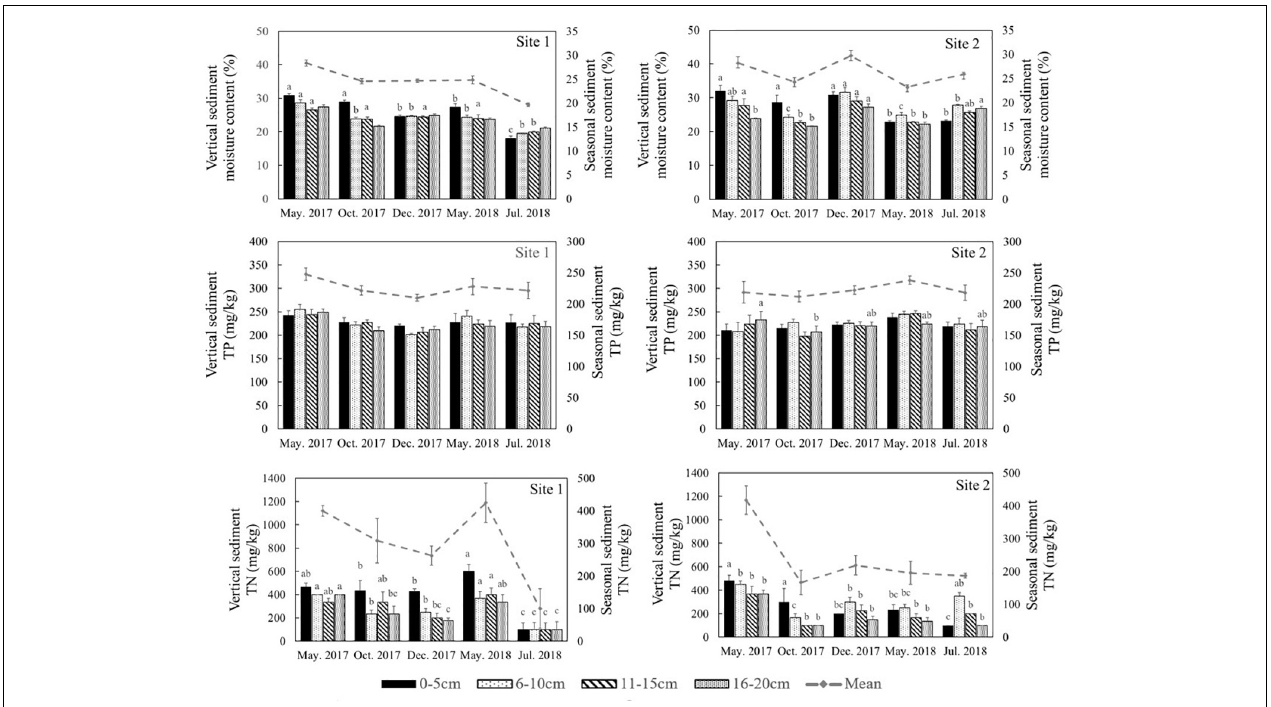
FIGURE 3 | Moisture content, total phosphorus (TP) and total nitrogen (TN) in different sediment layers in different seasons at the two sites in the Yellow River Delta. The dotted lines represent the seasonal mean values of all parameters. Different letters represent significant differences between different seasons in the sediment ( p <